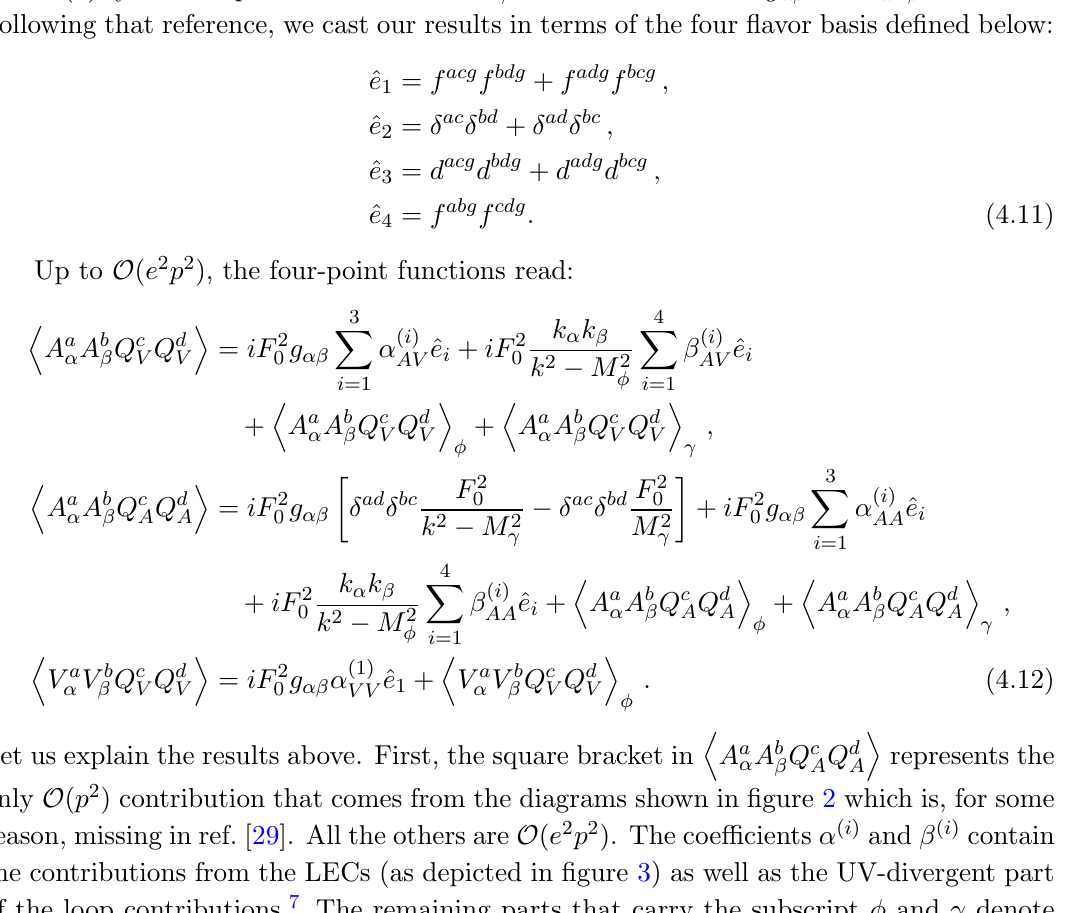
Figure 2 . O ( p 2 ) contributions to